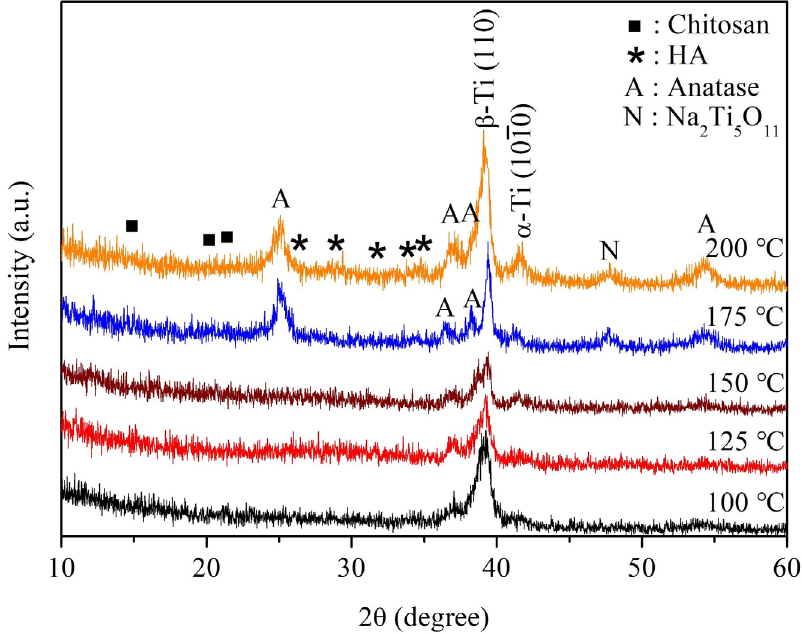
Figure 3. XRD patterns of HA/CS composite coatings on Ti–25Nb–8Sn alloy after alkali treatment and hydrothermal reaction at various temperatures.